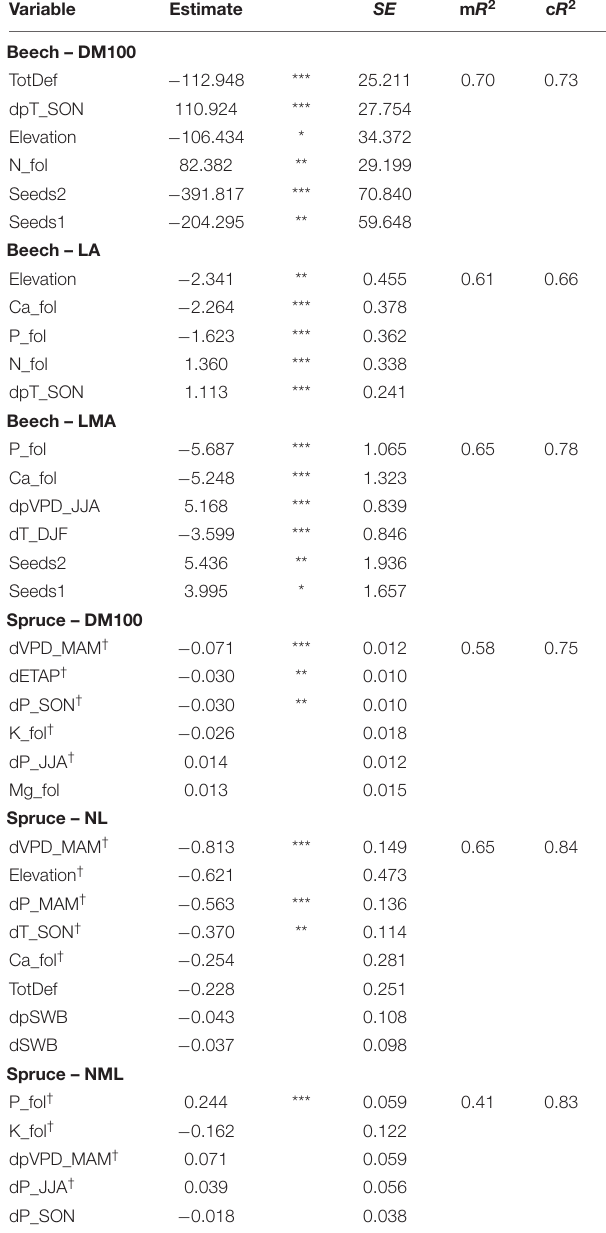
TABLE 4 | Temporal drivers of leaf morphological trait (LMT) variation.